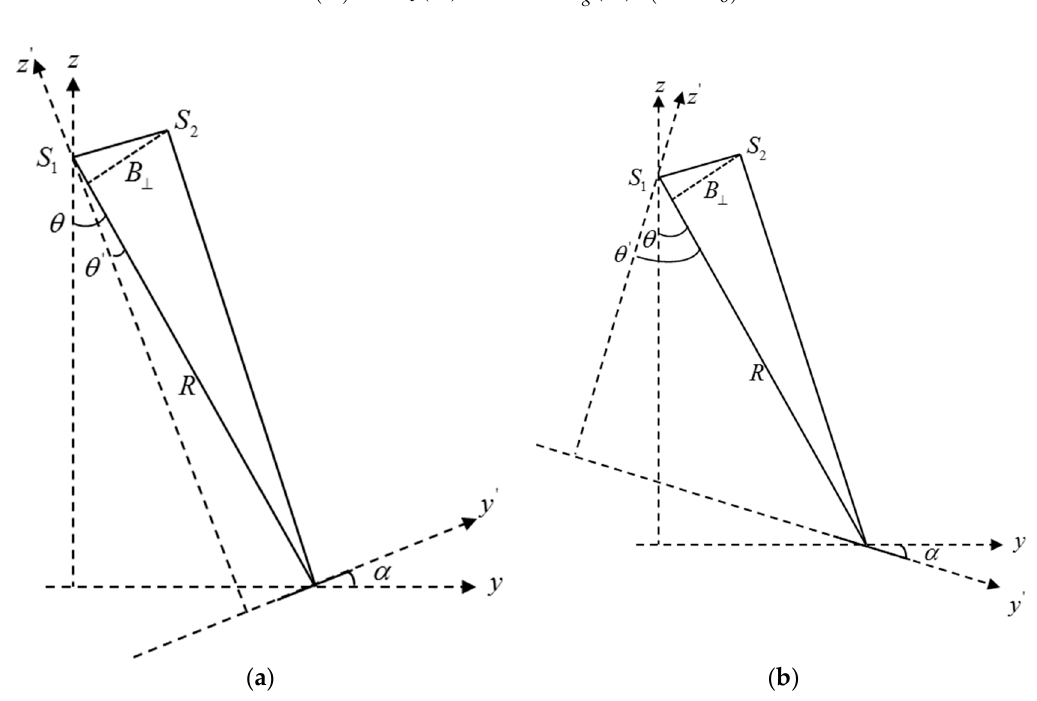
Figure 1. Geometrical reference frame for the sloped random volume over ground (S-RVoG) model. ( a ) Positive terrain slope; ( b ) Negative terrain slope. B ⊥ is the perpendicular baseline, θ is the incidence angle, R is the slant range, α is the range terrain slope, and θ (cid:48) is the incidence angle in the new geometric reference frame.